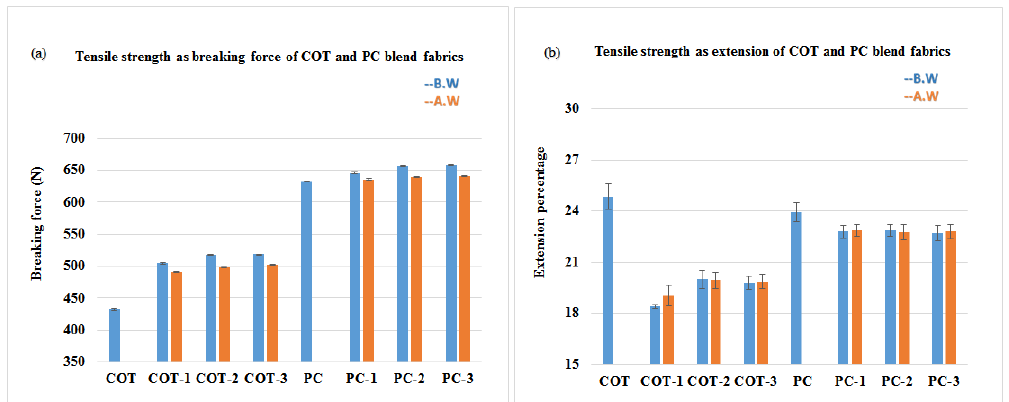
Figure 7. ( a ) Breaking force and ( b ) extension test for COT and PC fabrics.